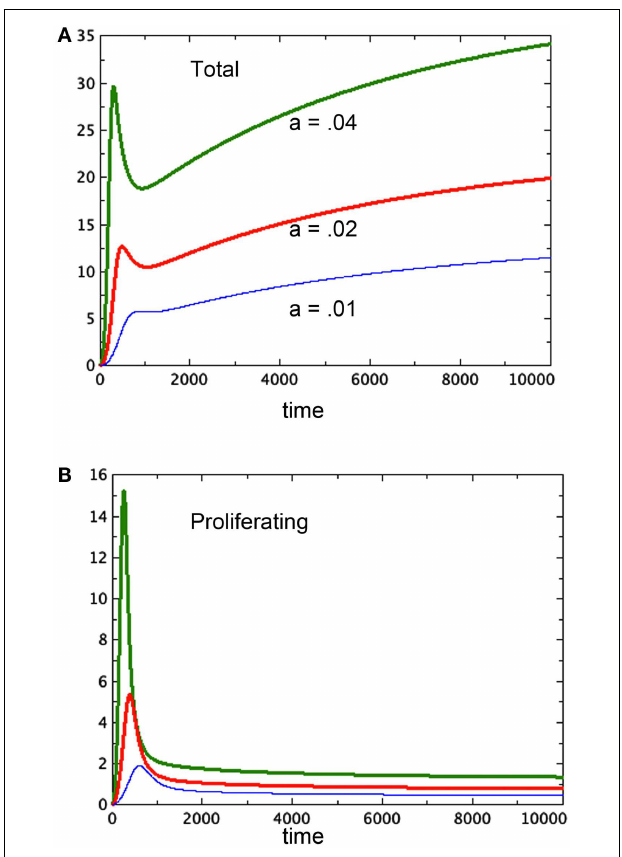
FIGURE 4 |Three runs of Model 3E with different growth factors as labeled. (A) Shows the total spheroid size and (B) shows the proliferating pool. As in Figure 2 , b P,Q = 0.01, c Q,P = 0.005, d = 0.002, e Q,N = 0.002, f = 0.01, h = 0, m = 0.0001, P 0 = 0.01, Q 0 = 0, N 0 =